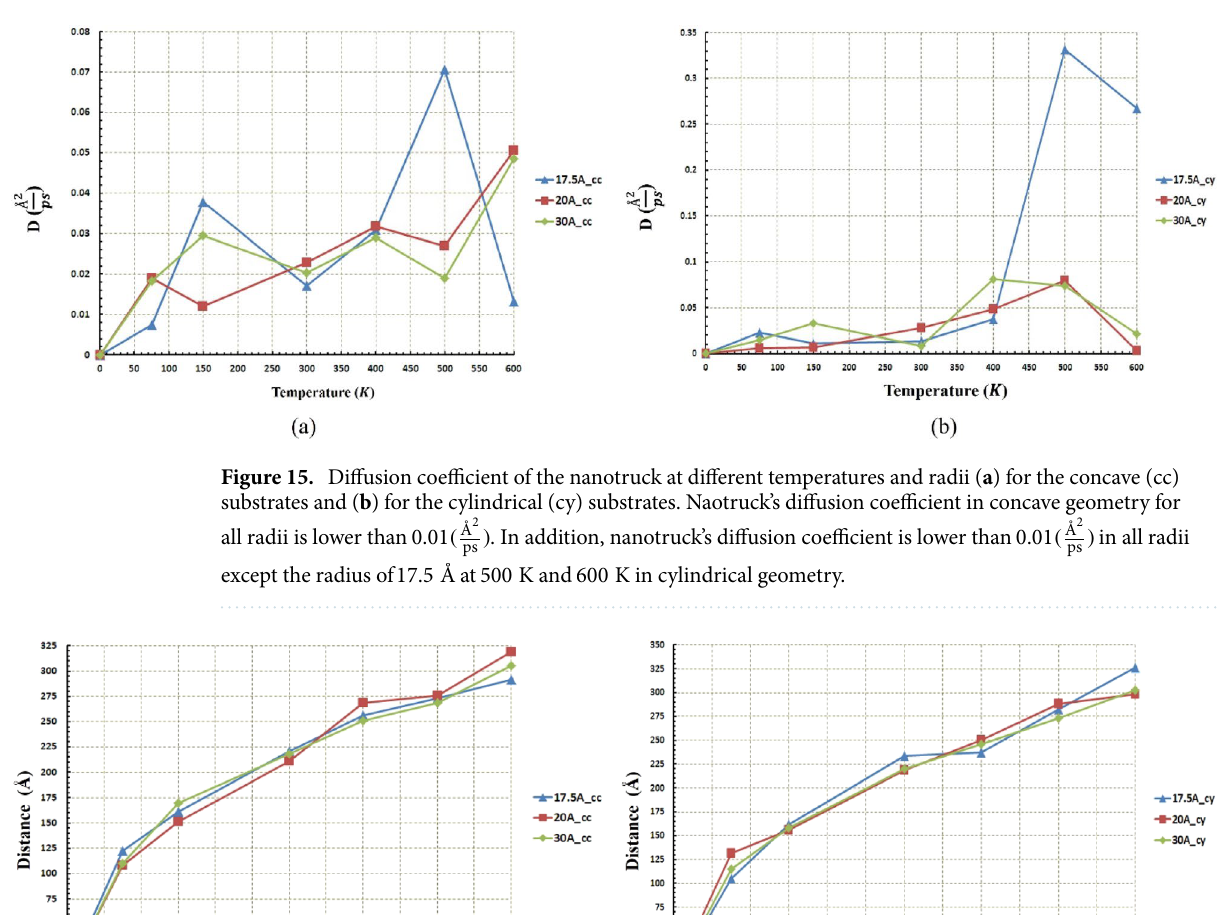
Figure 16. Distance traveled by the nanotruck at different temperatures and radii ( a ) for the concave (cc) substrates and ( b ) for the cylindrical (cy) substrates. The shape of the geometry and the radius do not affect the nanotruck’s distance traveled. Hence, at the same temperature, the distance traveled by nanotruck in both geometries and any radius is